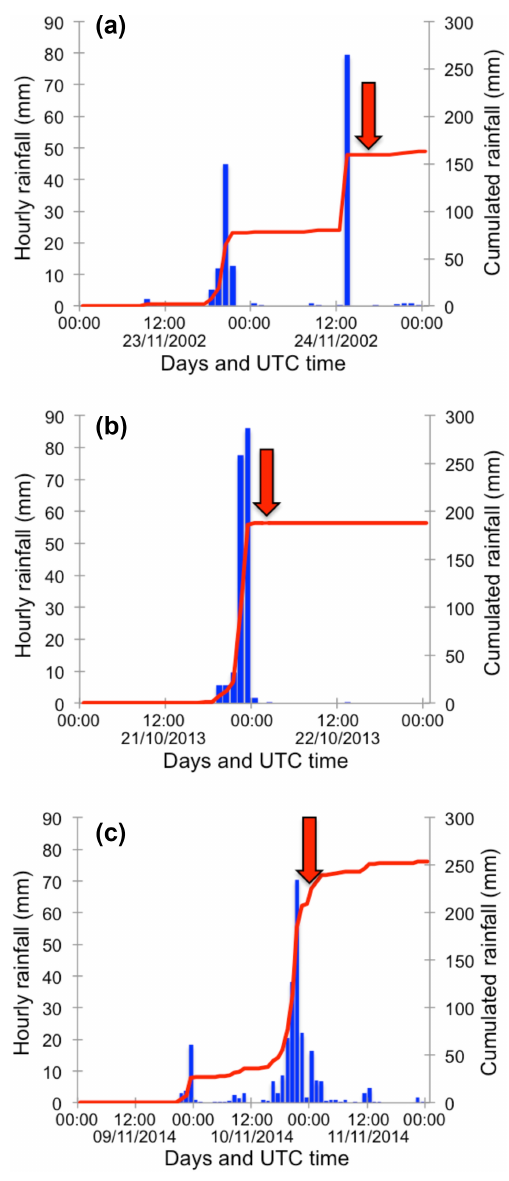
Figure 3. Hourly rainfall (blue bars) and cumulated event rain- fall (red line) for the three rainfall events considered in the Entella catchment (Table 1). (a) 23–24 November 2002 rainfall event mea- sured at the San Martino del Monte rain gauge. (b) 21–22 Octo- ber 2013 rainfall event measured at the Borzone rain gauge. (c) 9– 11 November 2014 rainfall event measured at the Panesi rain gauge. See Fig. 1 for location of the rain